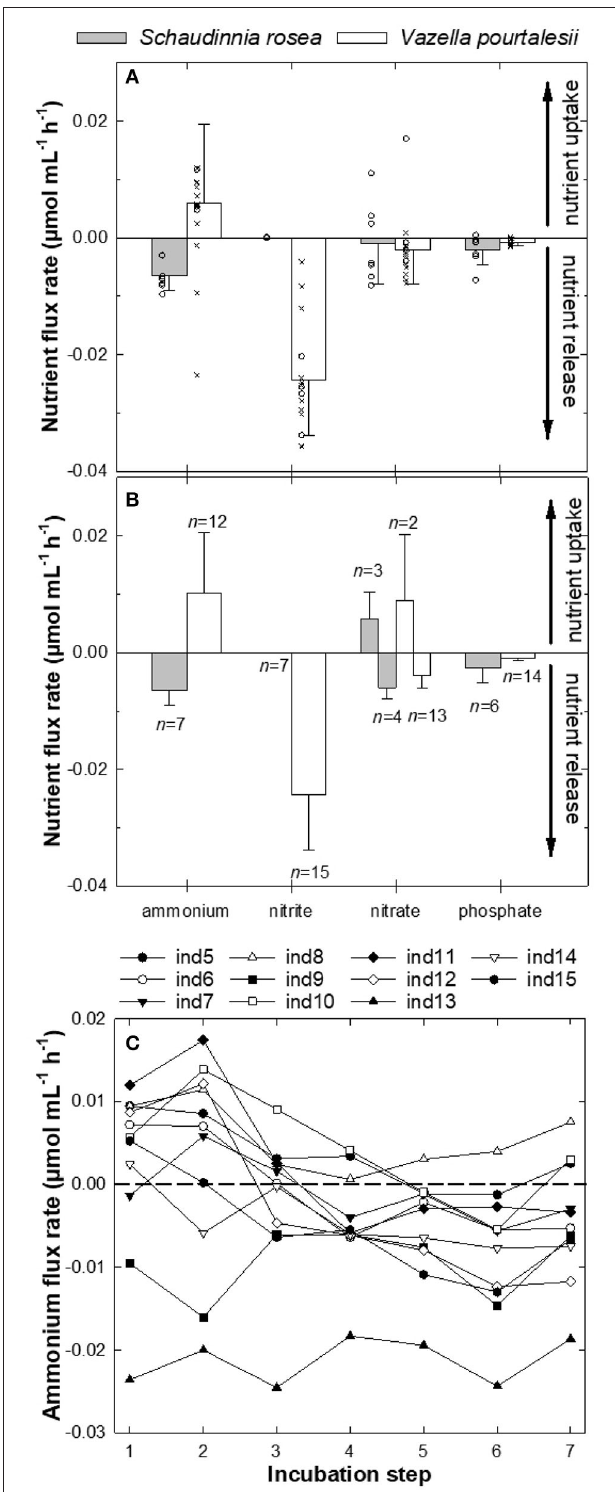
FIGURE 3 | (A,B) Magnitude (average ± SD) and sign of the flux ( µ mol mL − 1 h − 1 ) of ammonium (NH + 4 ), nitrite (NO − 2 ), nitrate (NO − 3 ), and phosphate (PO 3 − 4 ) measured for individuals of the hexactinellid sponges Schaudinnia rosea